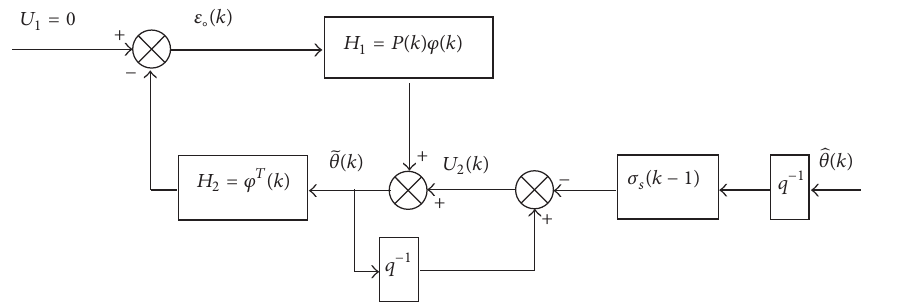
Figure 4: Closed-loop system of the parametric estimation